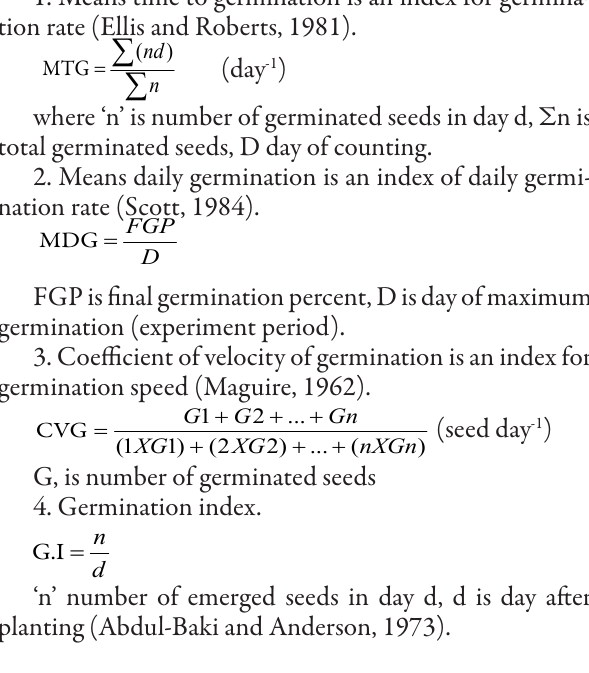
Tab. 1 represent a summary of the analysis of variance (ANOVA) for seed germination characteristics. Seed dete- rioration had significant effects on seed germination traits at the P<0.01 of probability, except of GU. It was signifi- cant at P<0.05 of probability. GP decreased significantly (P<0.01) as affected by deterioration levels according to Tab. 1.